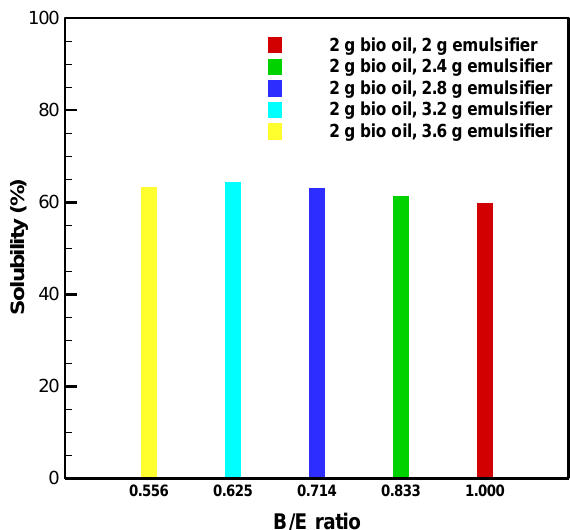
Figure 6. The solubility of bio-oil at different B/E ratios (2 g of bio-oil, fixed amount) at 100 °C for 7 days.